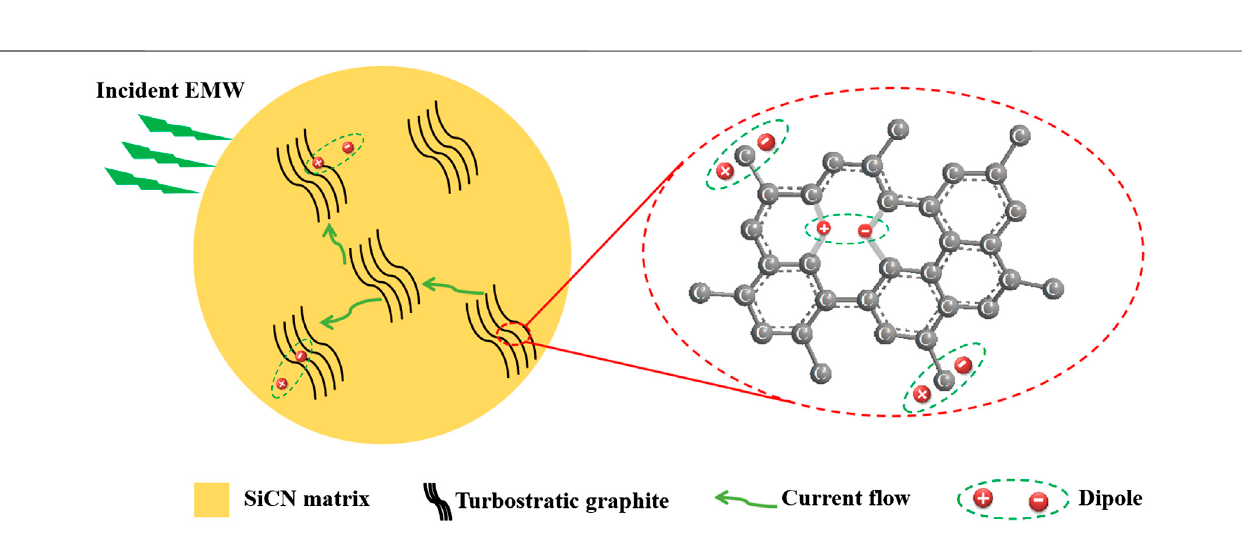
FIGURE 7 | Schematic diagram of the proposed mechanism for EMW